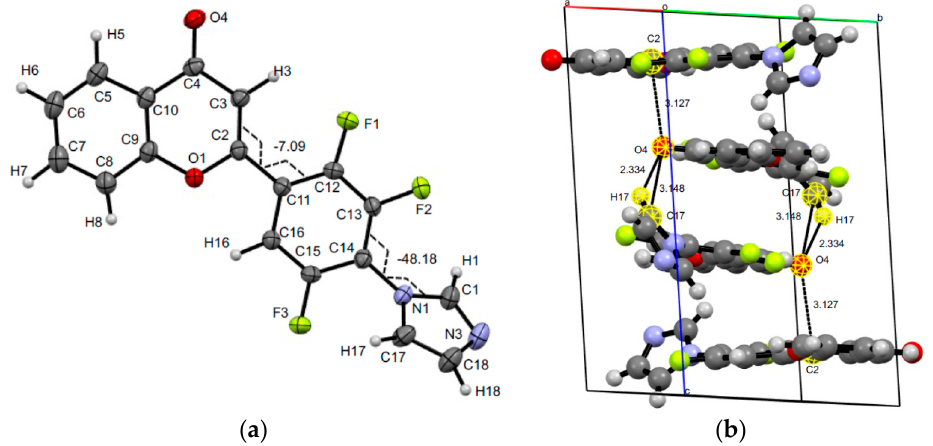
Figure 4. Molecular structure and selected torsions ( a ), and unit cell ( b ) of compound 15 with atoms represented as thermal ellipsoids of thermal vibrations with a 50% probability.